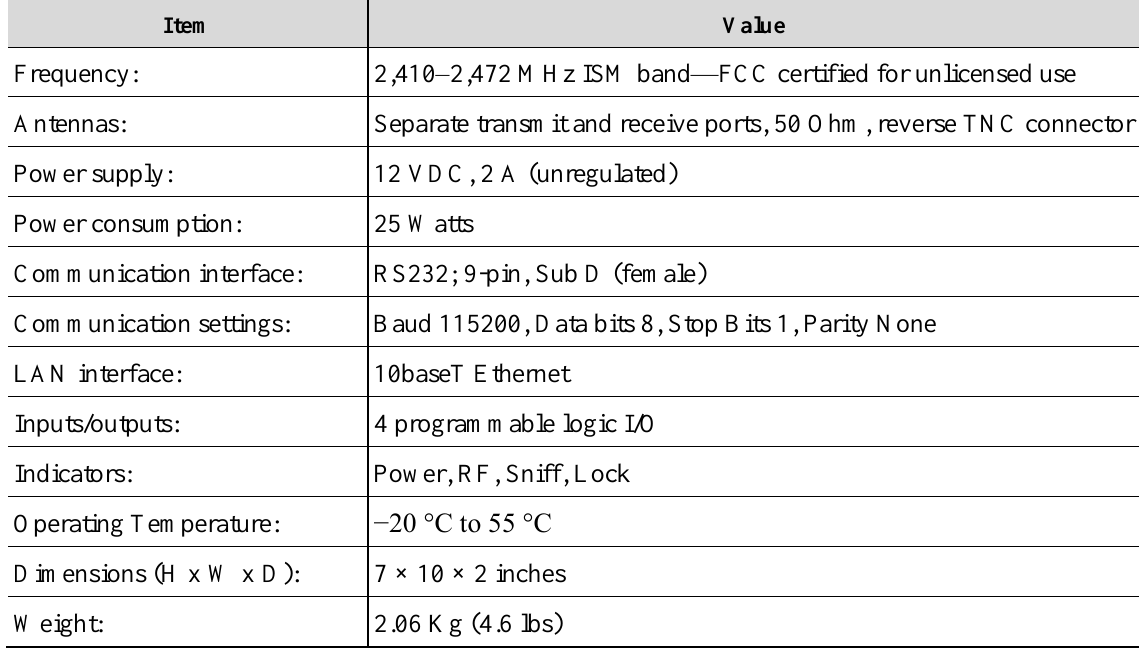
Table 3. Hardware type and specifications of the RFID.